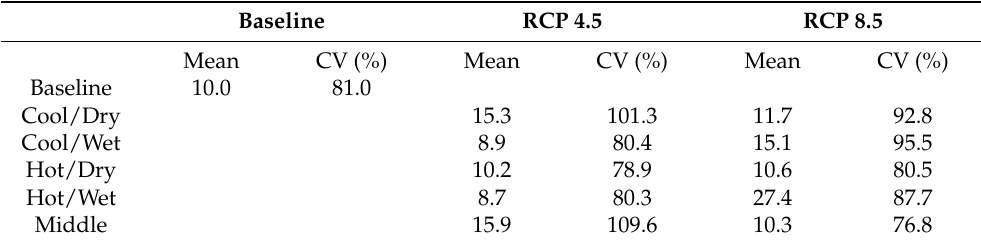
Table 5. Delay in rainfall at the start of the season as predicted by GCMs. Baseline RCP